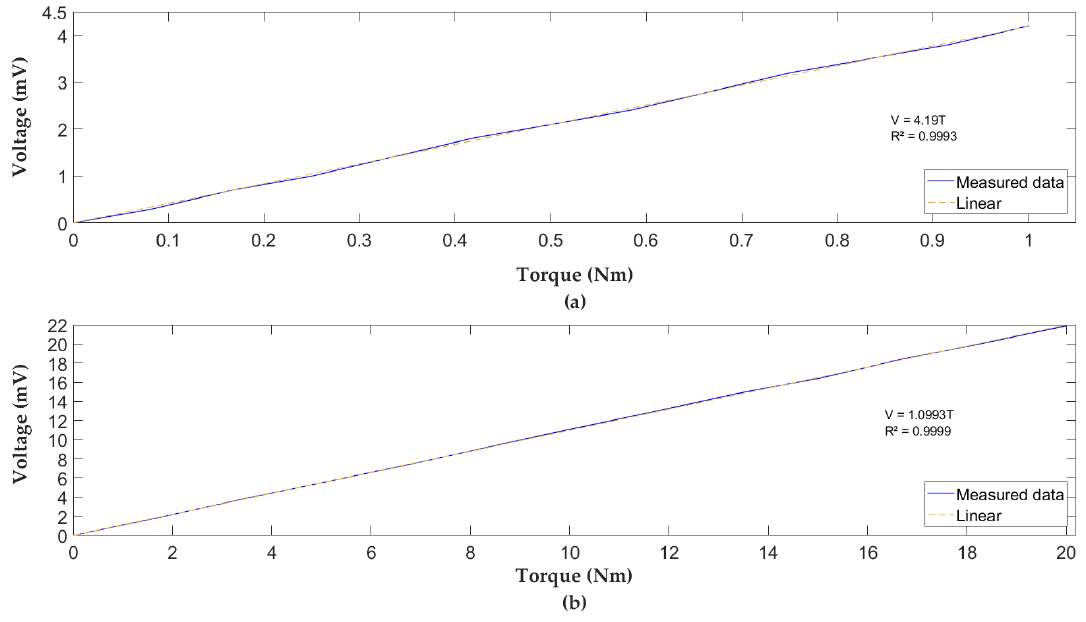
Figure 16. Graph bridge output voltage vs. applied torque: ( a ) 1 Nm Sensor, ( b ) 20 Nm.